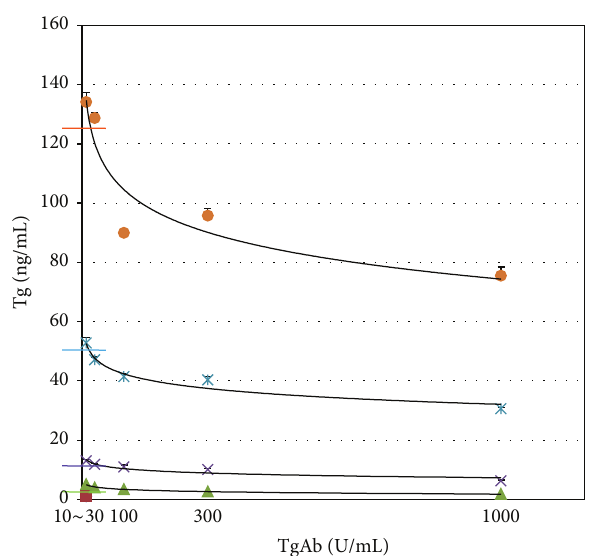
Figure1:MeasuredTgconcentrationshowedaproportionaldecline according to increase of TgAb concentration in every sample produced using standard solutions. Transverse color bars represent expected Tg concentrations of each